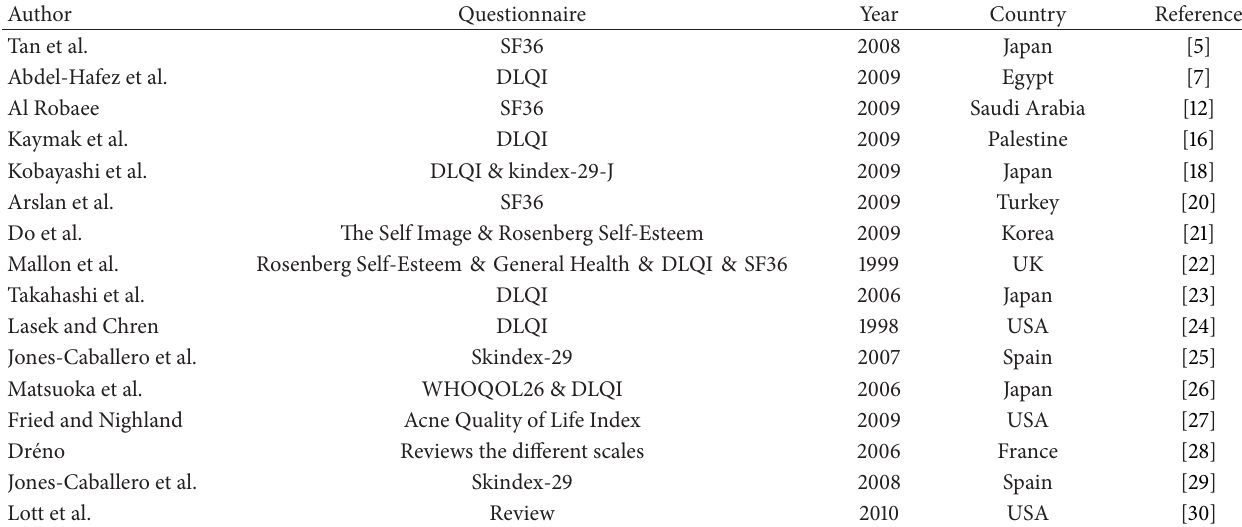
Table 5: The summary of previous studies that looked at QOL in